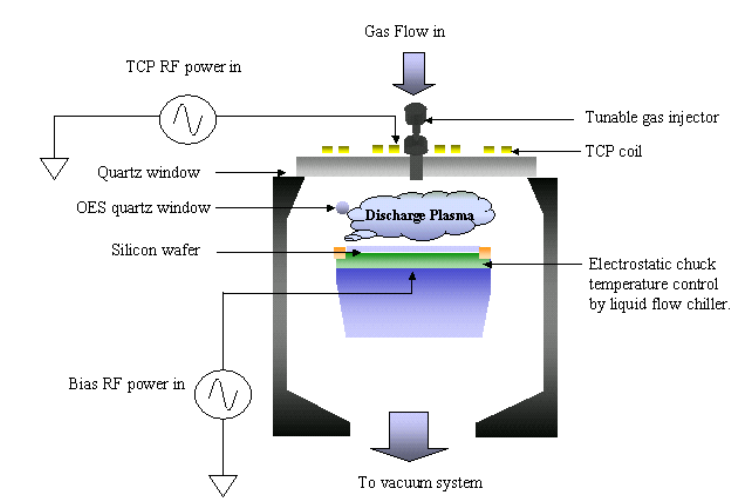
Figure 2. The configuration of the